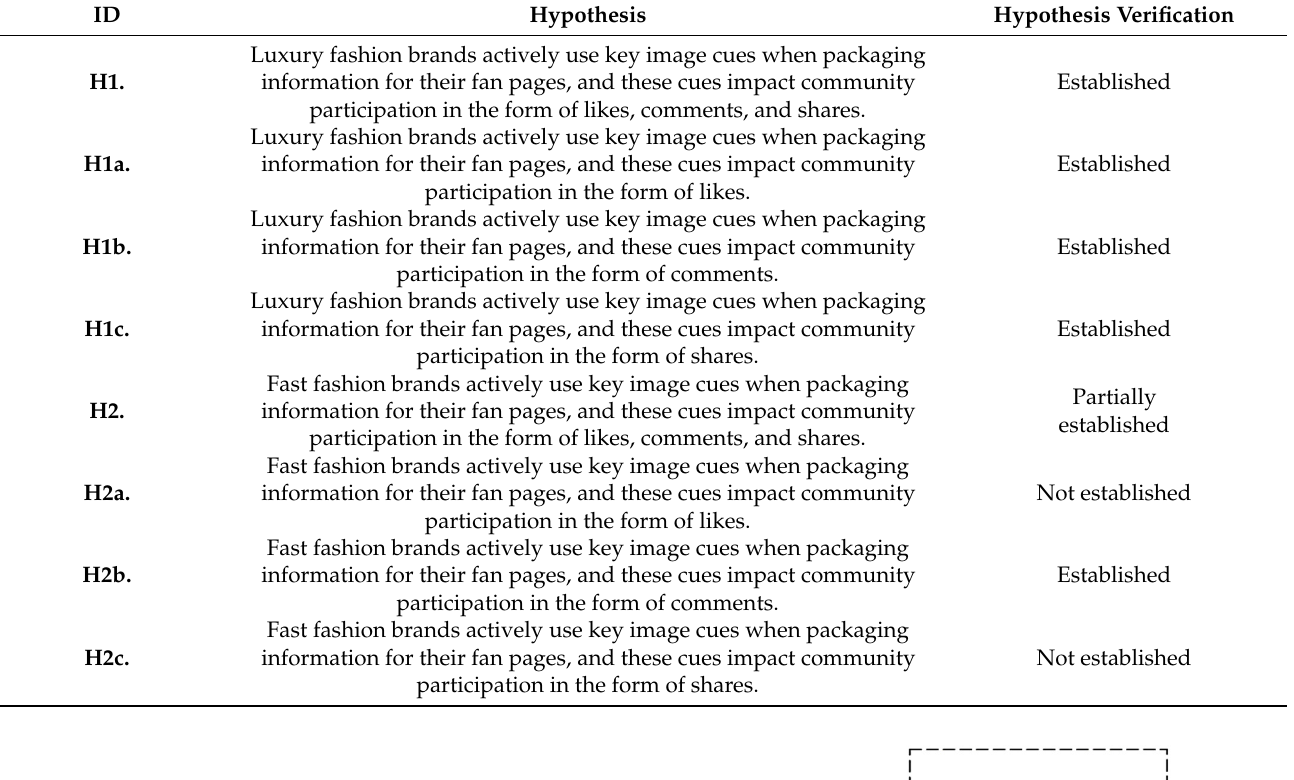
Table 1. Summary of hypothesis.